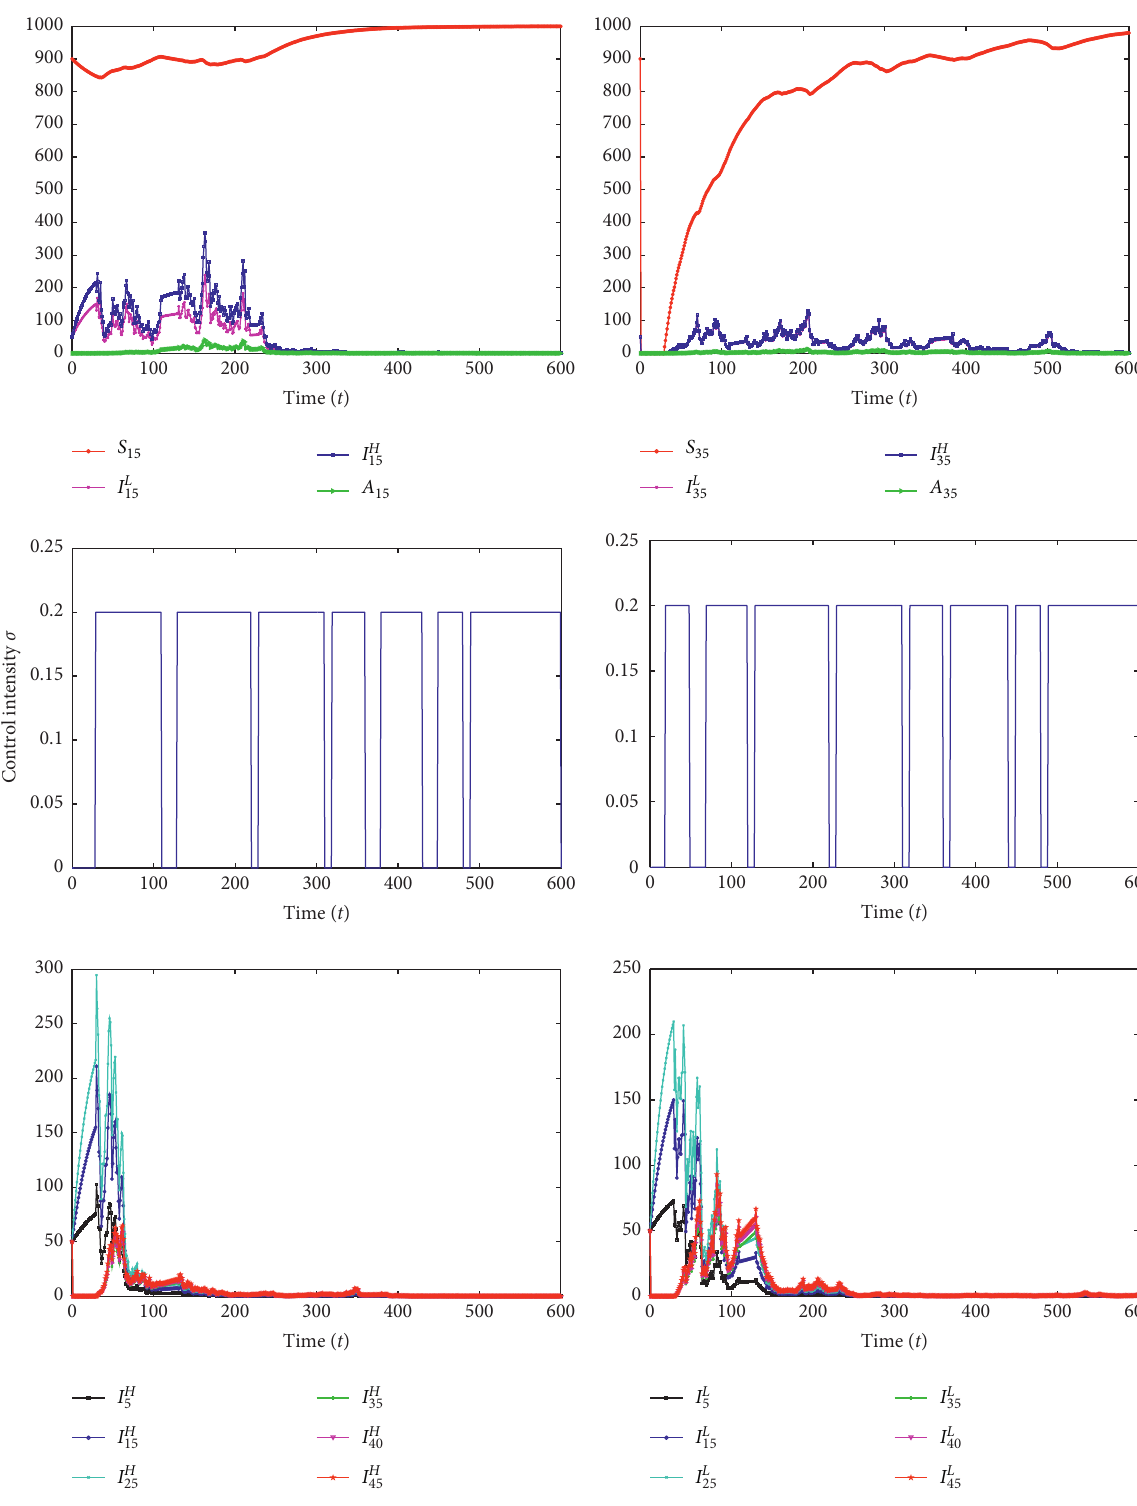
Figure 5: The time series and orbits of system (7) with R > 1 and stochastic control. The top two pictures are the sample paths of 0 S ( t ) ,I L ( t ) ,I H ( t ) ,A ( t ) and S ( t ) , I L ( t ) , I H ( t ) , A ( t ) . The middle pictures are two different time strategies with τ � 0 . 8 and σ � 0 . 2. 15 15 35 35 15 15 35 35 The last two pictures are sample paths of I L ( t ) and I H ( t ) with degree k � 5 , 15 , 25 , 35 , 40 , 45. The malware will be extinct in the